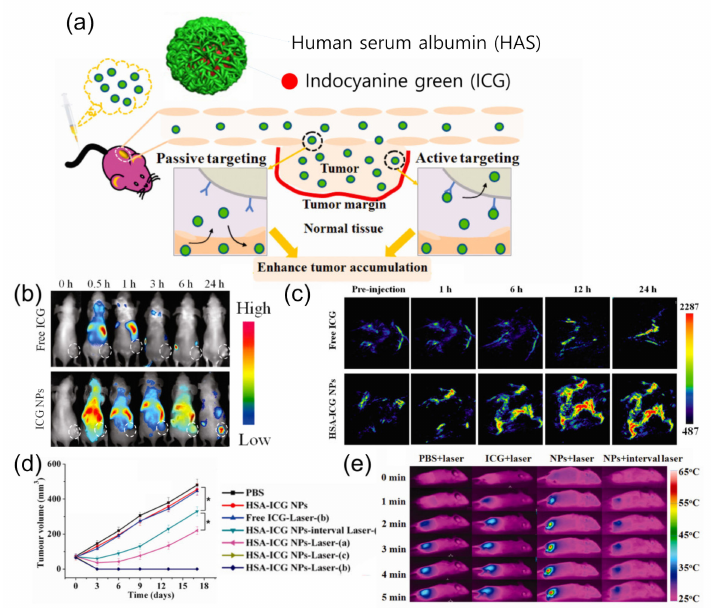
Figure 2. ( a ) Scheme of HSA-ICG nanoparticles for enhanced tumor accumulation in 4T1 tumors by passive (EPR effect) and active (gp60 transcytosis pathway) targeting; ( b ) fluorescence imaging of 4T1 tumor-bearing mice after the injection of free ICG (upper) and HSA-ICG nanoparticles (lower) at different time intervals; ( c ) photoacoustic imaging of the mice; ( d ) tumor growth curves after different treatments (* p < 0.05, a: partial irradiation, b: accurate irradiation, c: over irradiation); ( e ) thermal images of mice exposed to 808 nm laser for 5 min. Figures are reproduced from ref. [58] with permission from the American Chemical